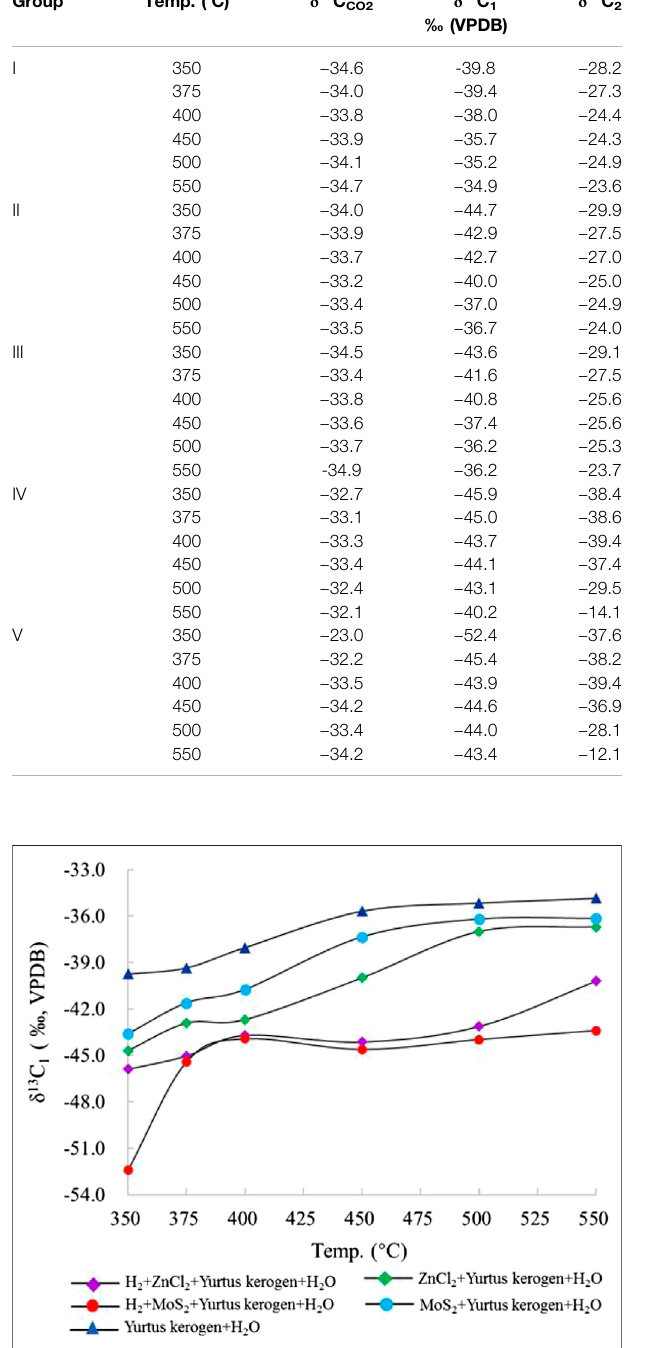
FIGURE 5 | Change in δ 13 C 1 simulated under different catalytic hydrogenation control conditions of the closed system.